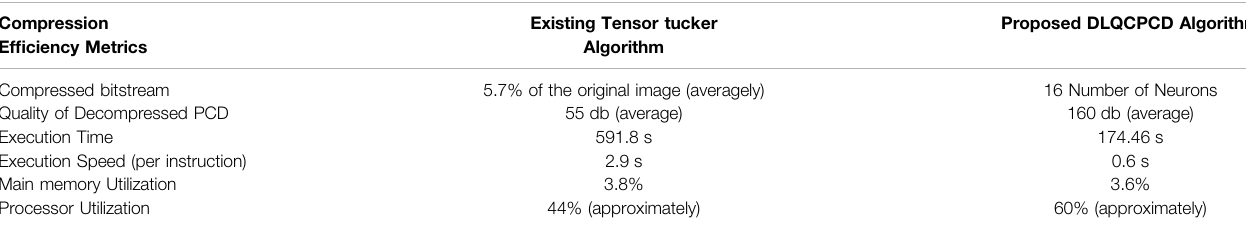
TABLE 5 | Ef fi ciency comparison between the existing and proposed